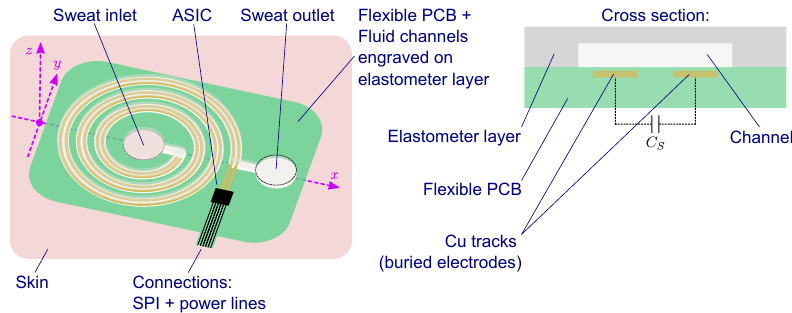
Figure 1. Concept of a wearable platform for volumetric sweat-rate